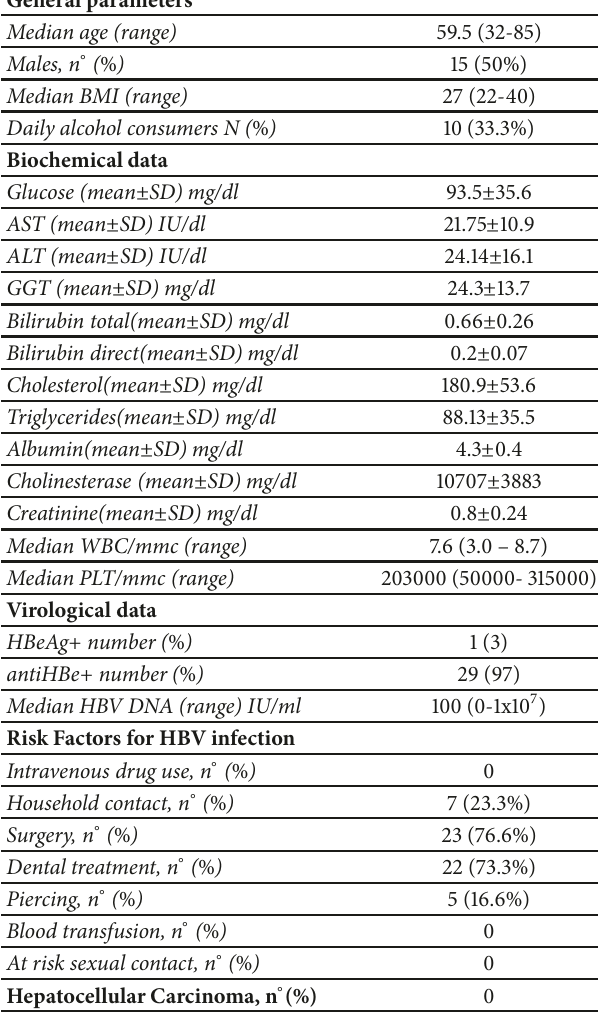
Table 2: Characteristics of 30 patients